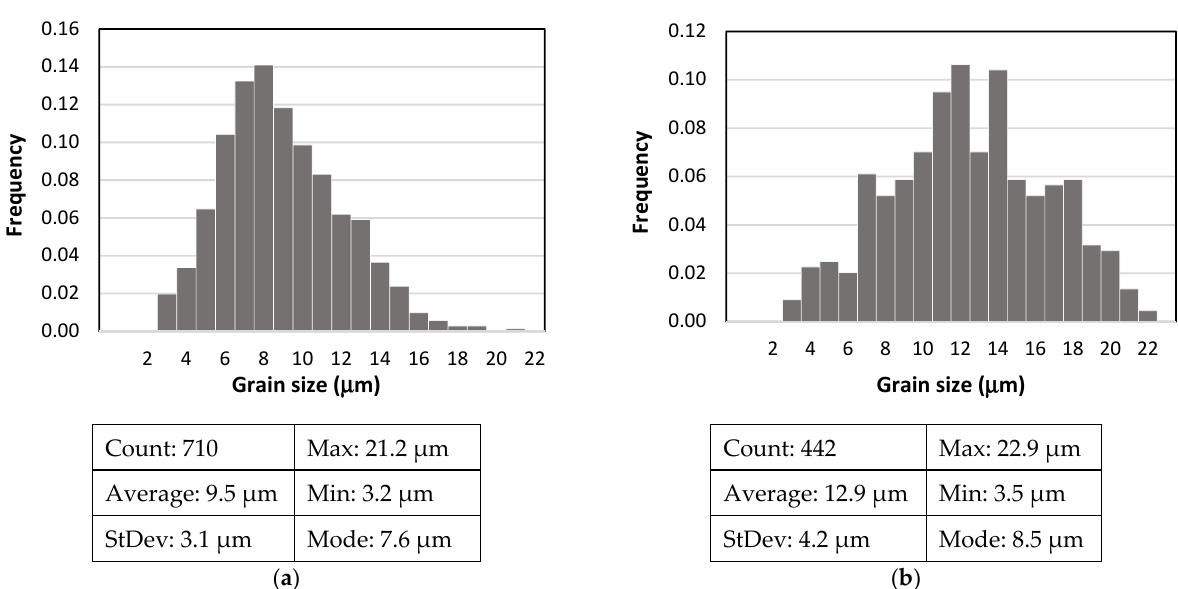
Figure 7. Grain size distribution of AISI 904L steel after cold rolling at 50% and annealing at ( a ) 1050 °C for 40 s and ( b ) 1150 °C for 20 s.